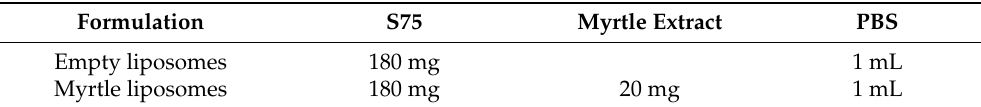
Table 1. Composition of the liposome